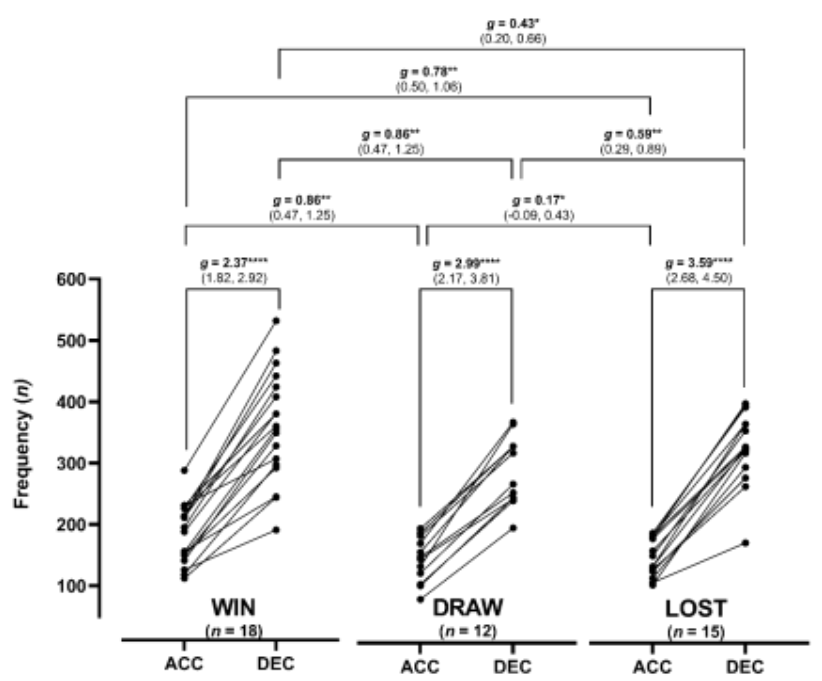
Figure 1. Total team frequency and effect size differences in high-intensity accelerations and decelerations completed during matches with win, draw and lost performance outcomes. Effect size differences displayed as: * = small, ** = moderate, **** = very large.